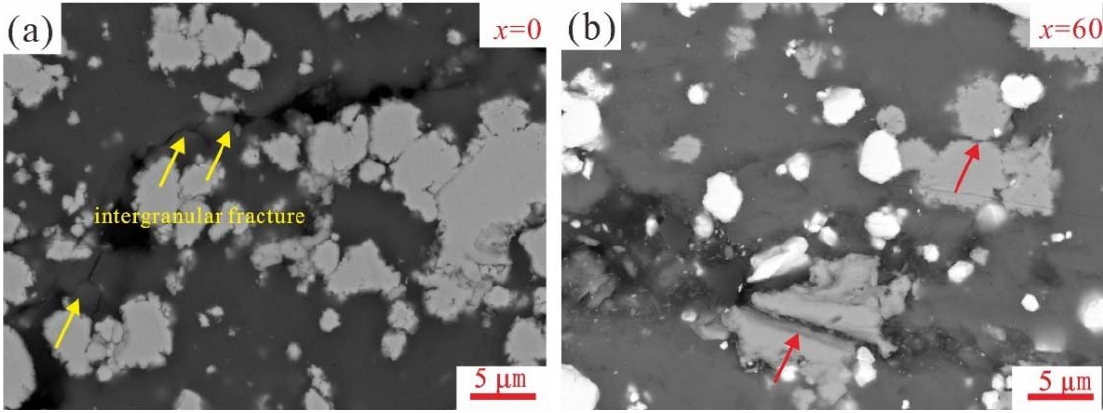
Figure 9. Crack propagation for (48Al–52Ni) 100- x W x composites during compression. ( a ) x = 0; ( b ) x = 60.